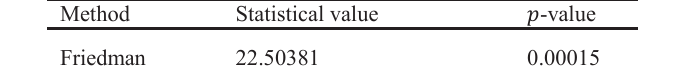
Table 10. Results of Friedman’s test based on the average best-so-far for unimodal test functions of set 1.